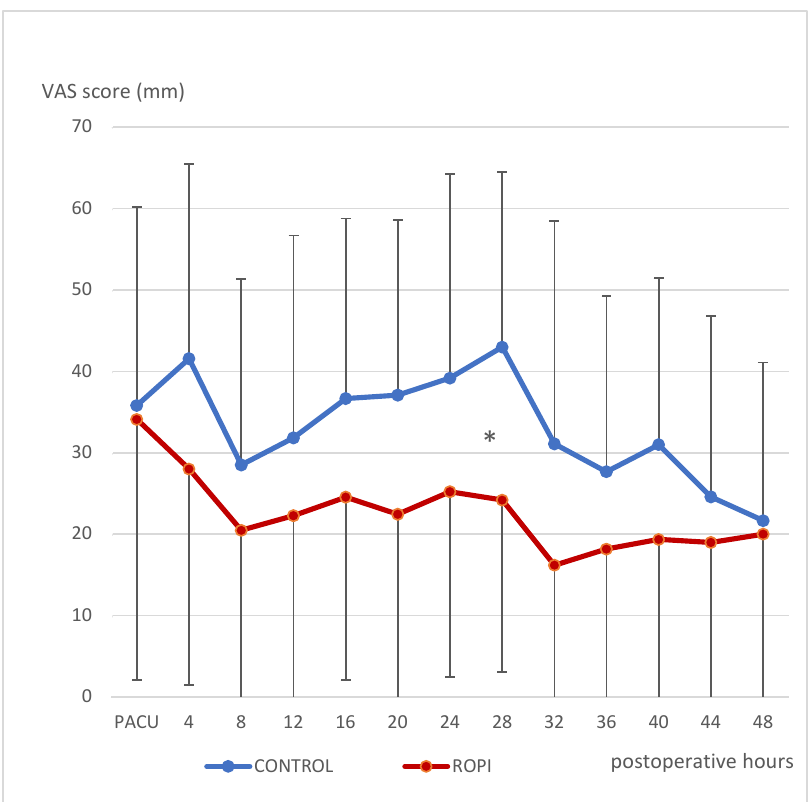
Figure 2. Pain scores at rest (VAS mm) at fibula harvest site. Mean and SD vs. postoperative time (hours) starting in PACU. * p < 0.05. No significant difference was observed between groups in pain score at the cervical site (Figure 3).